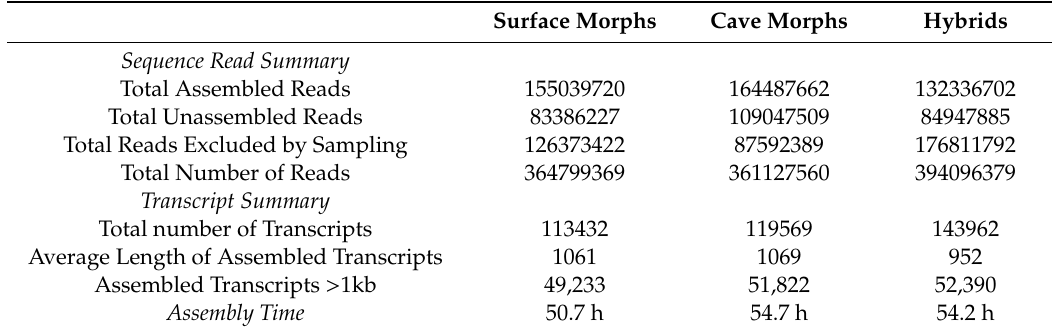
Table 1. Comparison of transcriptome assemblies of Asellus cave morphs, surface morphs and hybrid